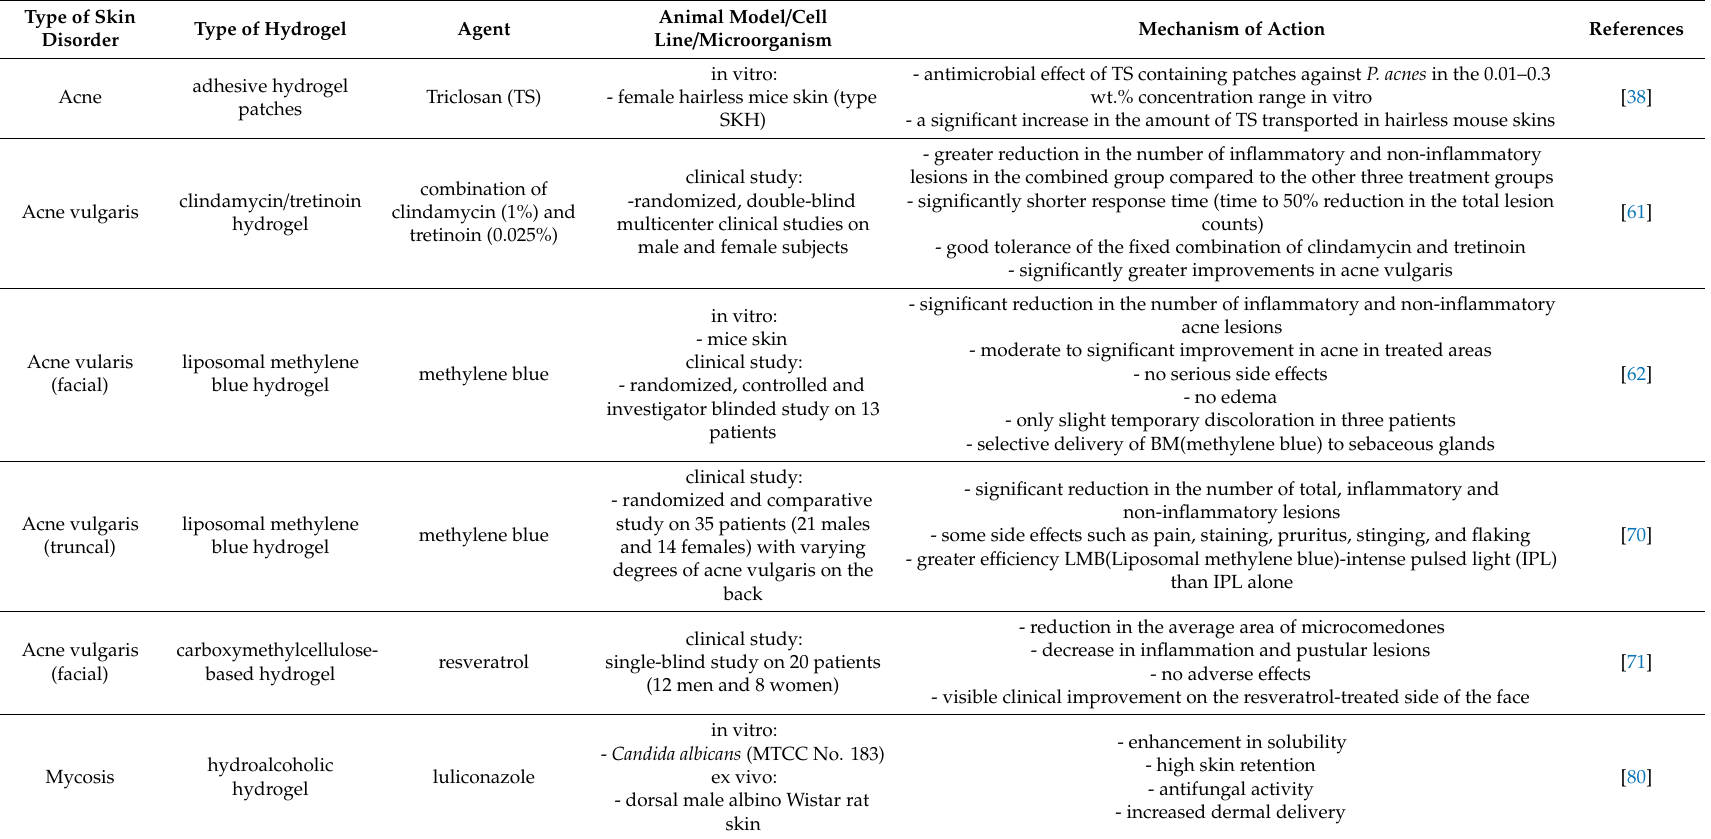
Table 1. Application of hydrogels in the treatment of skin